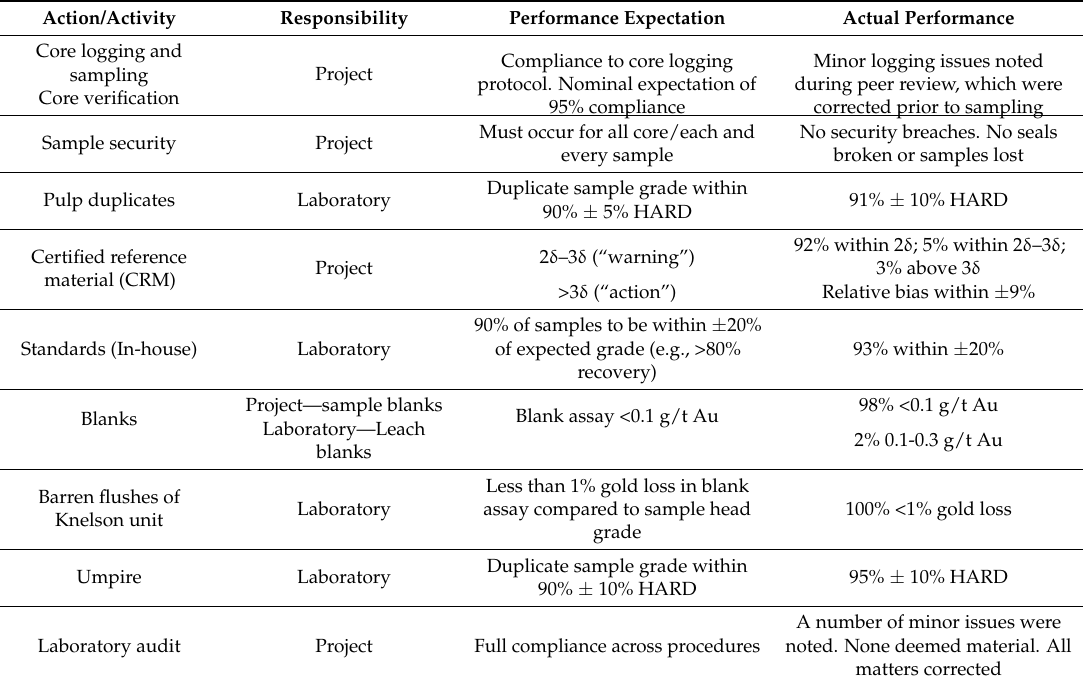
Table 6. Summary of geometallurgical drilling programme QAQC programme